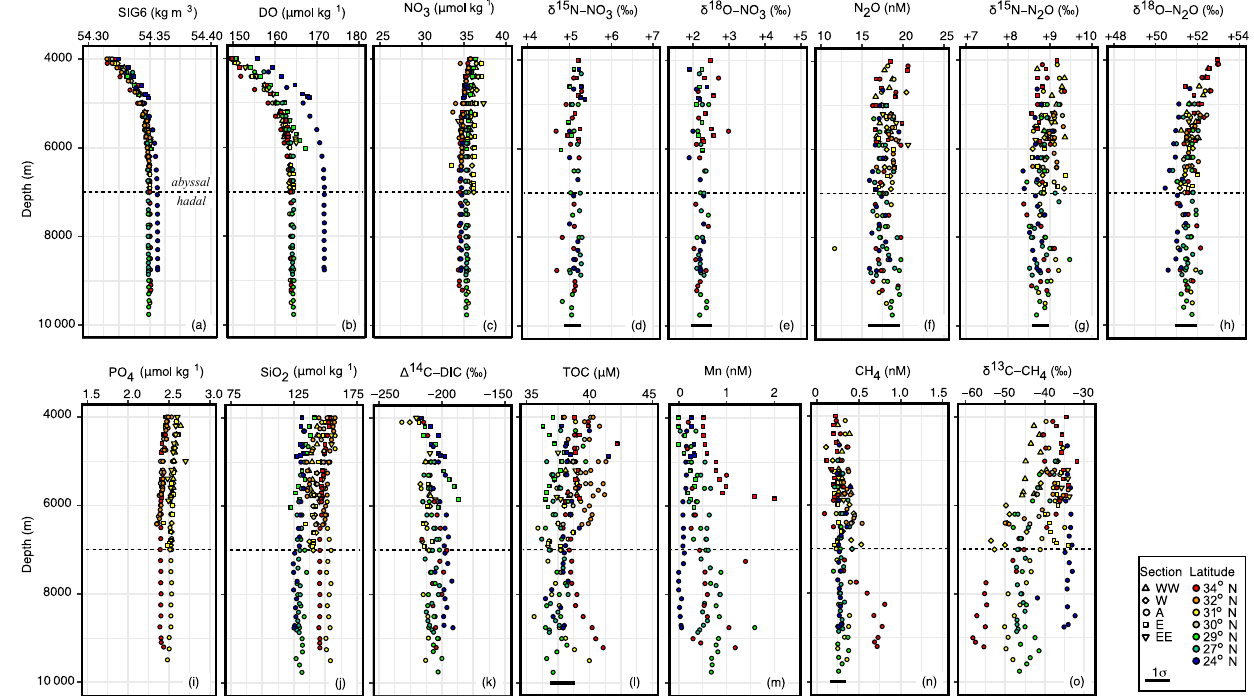
Figure 2. Vertical profiles of measured parameters. Symbol shapes and colors are classified by locations relative to the axis and latitude, respectively (see Table 1). Horizontal dashed lines indicate the abyssal–hadal boundary. Bold horizontal lines shown at the bottom of each panel represent 1 σ analytical errors, but this is not shown when the errors are smaller than the symbol